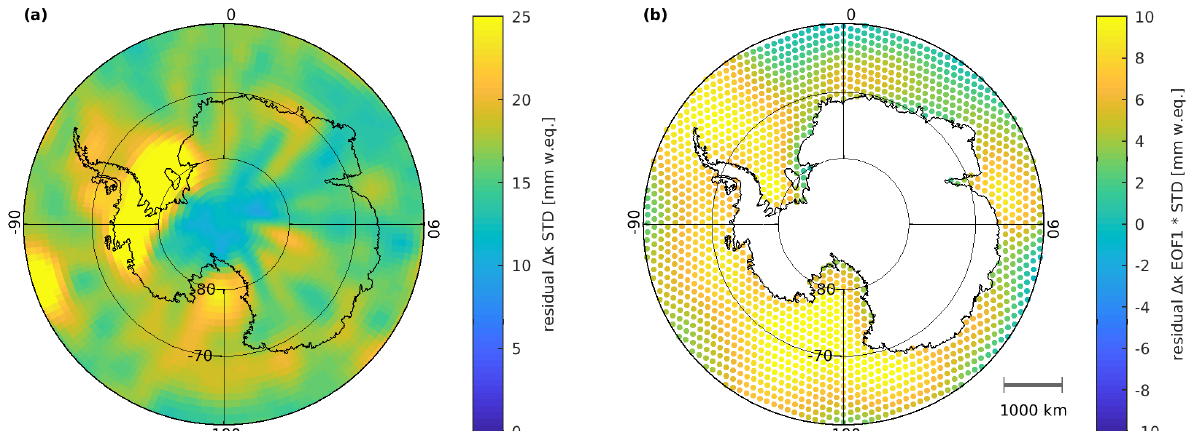
Figure 1. Residual surface density anomalies with respect to the standard model derived from filtered CSR RL06 monthly solutions (corrected for cumulative surface mass balance anomalies over the Antarctic Ice Sheet): ( a ) standard deviation and ( b ) first empirical orthogonal function (EOF) from a principal component analysis of the residuals over the adjacent ocean. The spatial pattern in ( b ) is scaled by the standard deviation of the corresponding principal component.